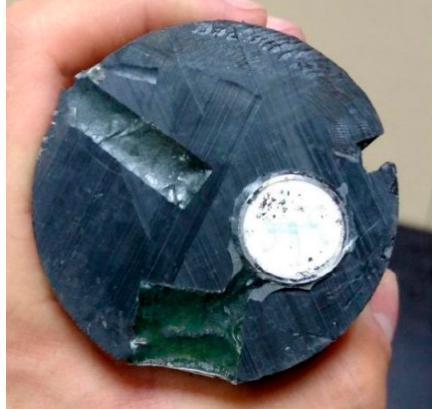
Figure 6. Micro earth pressure sensor in the pile end.